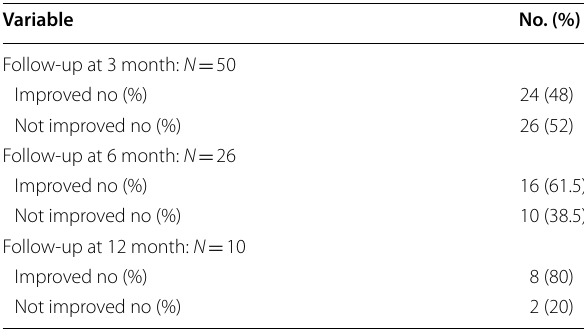
Table 3 Number of patients improved after different